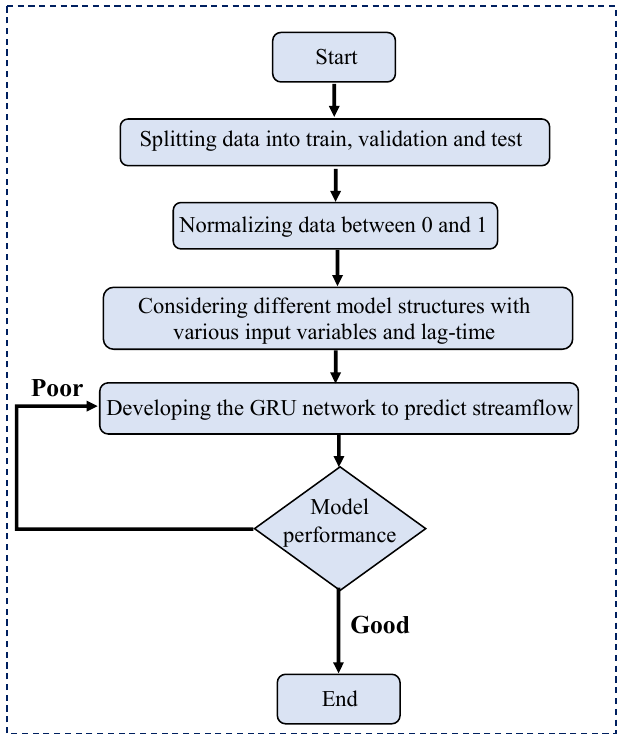
Figure 3. Flowchart of GRU modeling procedure.